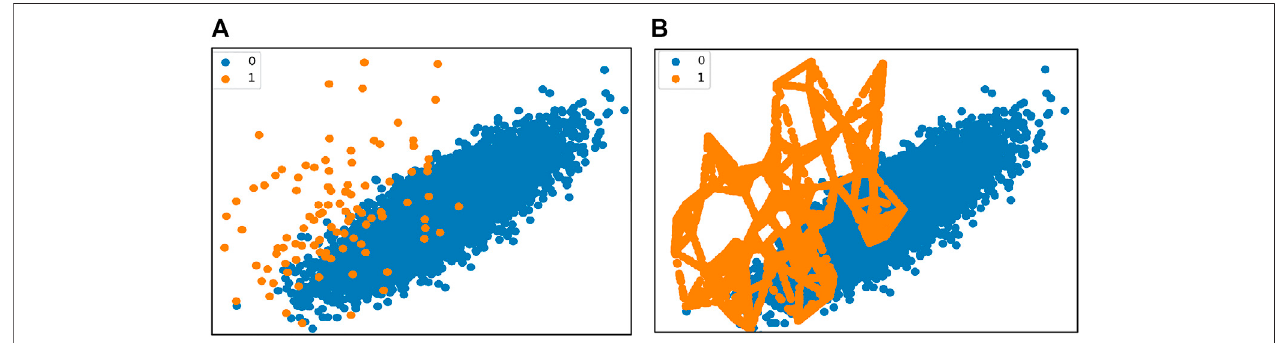
FIGURE5|(A,B) Graphofthedatapointdistribution (A) presentstheinitialimbalanceddataset,whereorangepointsareevents(one)andbluepointscorrespond to the quiet state (zero); (B) after the application of SMOTE the previous graph transforms to a balanced one.